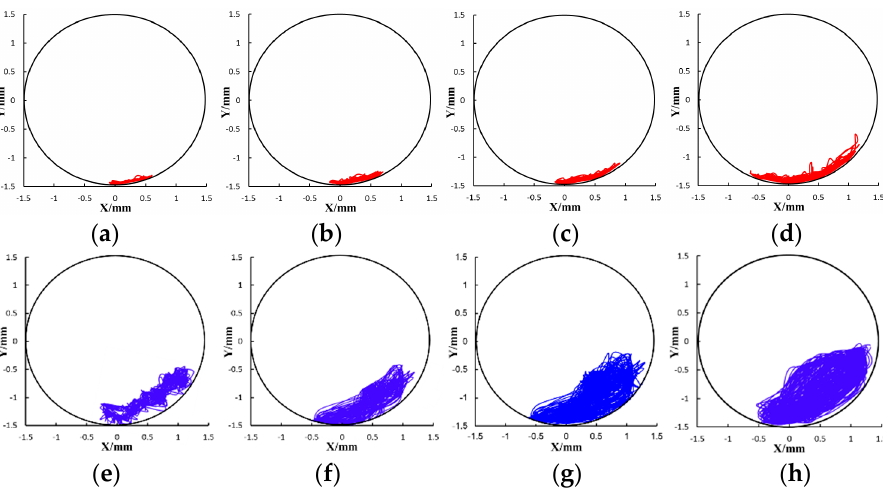
Figure 9. Trajectory curve of BHA center under different rotating speeds: ( a ), ( b ), ( c ), and ( d ) are the numerical simulation results with 100 r/min, 300 r/min, 500 r/min, and 700 r/min respectively; ( e ), ( f ), ( g ), and ( h ) are the experimental results with 100 r/min, 300 r/min, 500 r/min, and 700 r/min respectively. Table 8. Lateral displacement of BHA under different rotate speeds in numerical simulation.